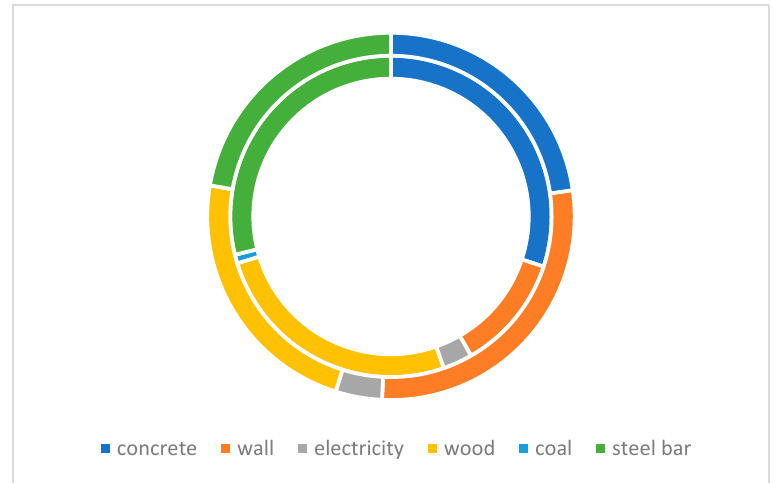
Figure 6. Carbon emissions of field installation in this project.